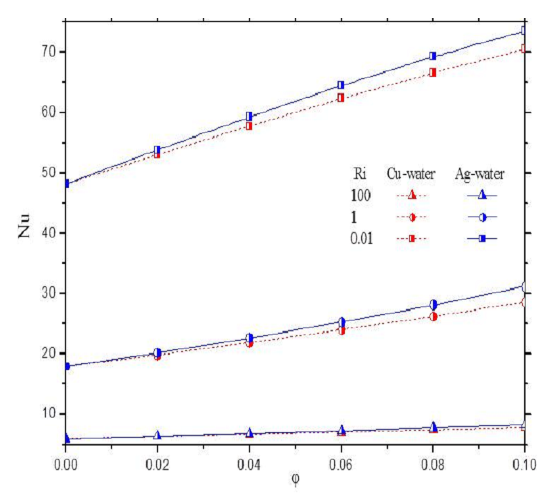
Figure 4: Variation of the mean Nusselt number with the nanoparti- cles volume fraction for different values of Ri .